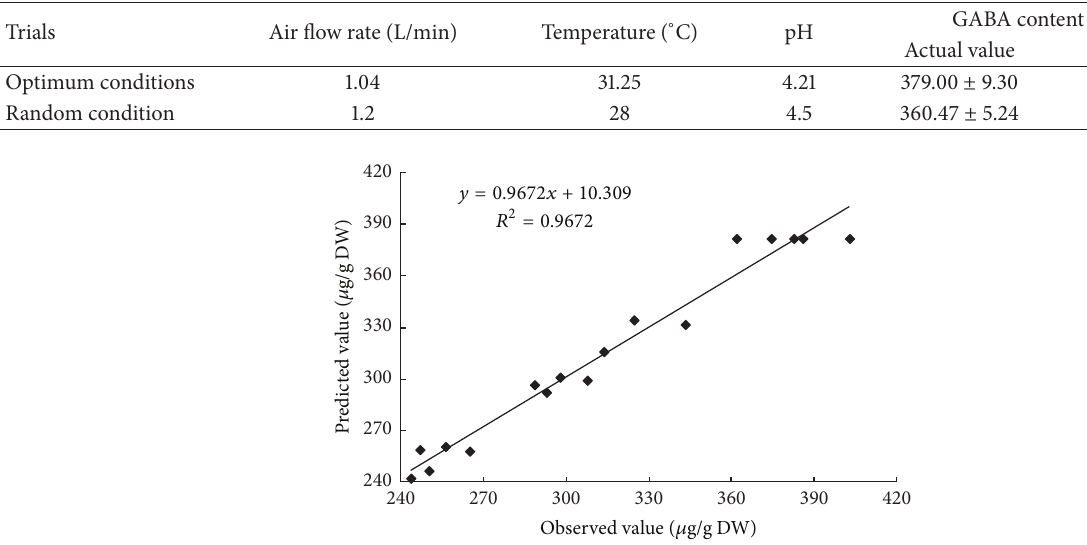
Figure 3: Correlation between predicted and observed values of GABA content.